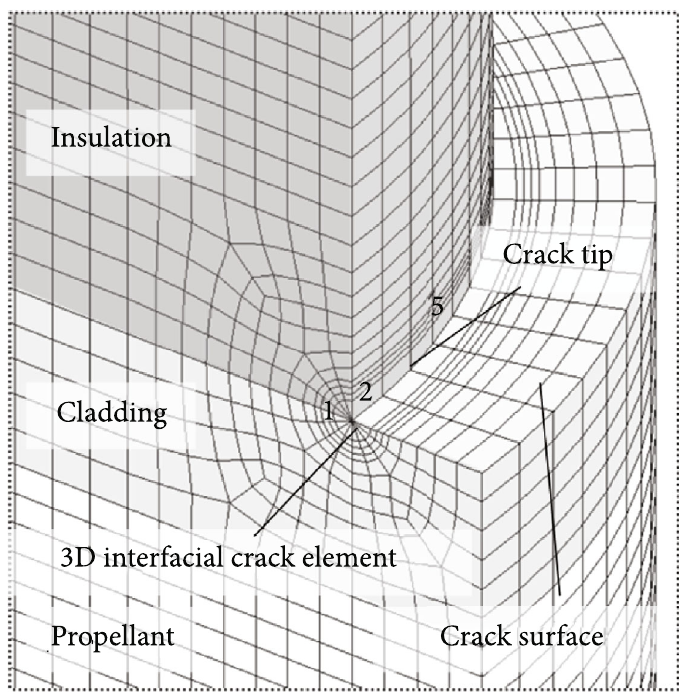
Figure 5: The interface debonded specimen model and 3D interfacial crack element meshing.